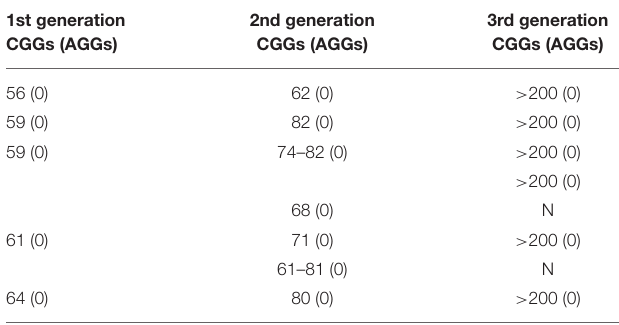
TABLE 3 | Results of triplet studies in different generations of families where the index case presented 0 AGG interruptions in her